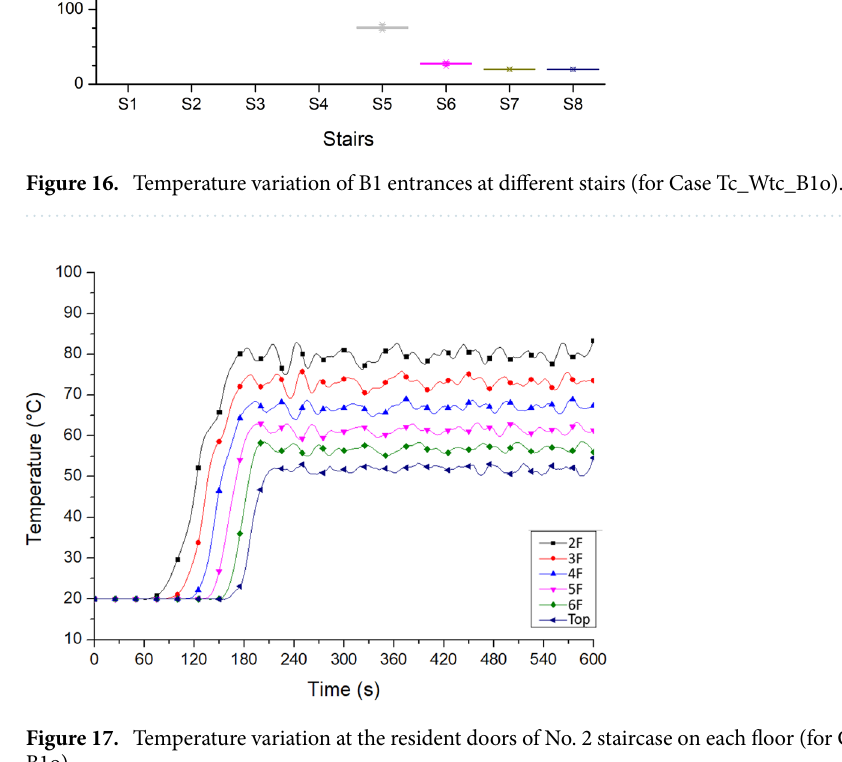
Figure 17. Temperature variation at the resident doors of No. 2 staircase on each floor (for Case To_WAo_ B1o).